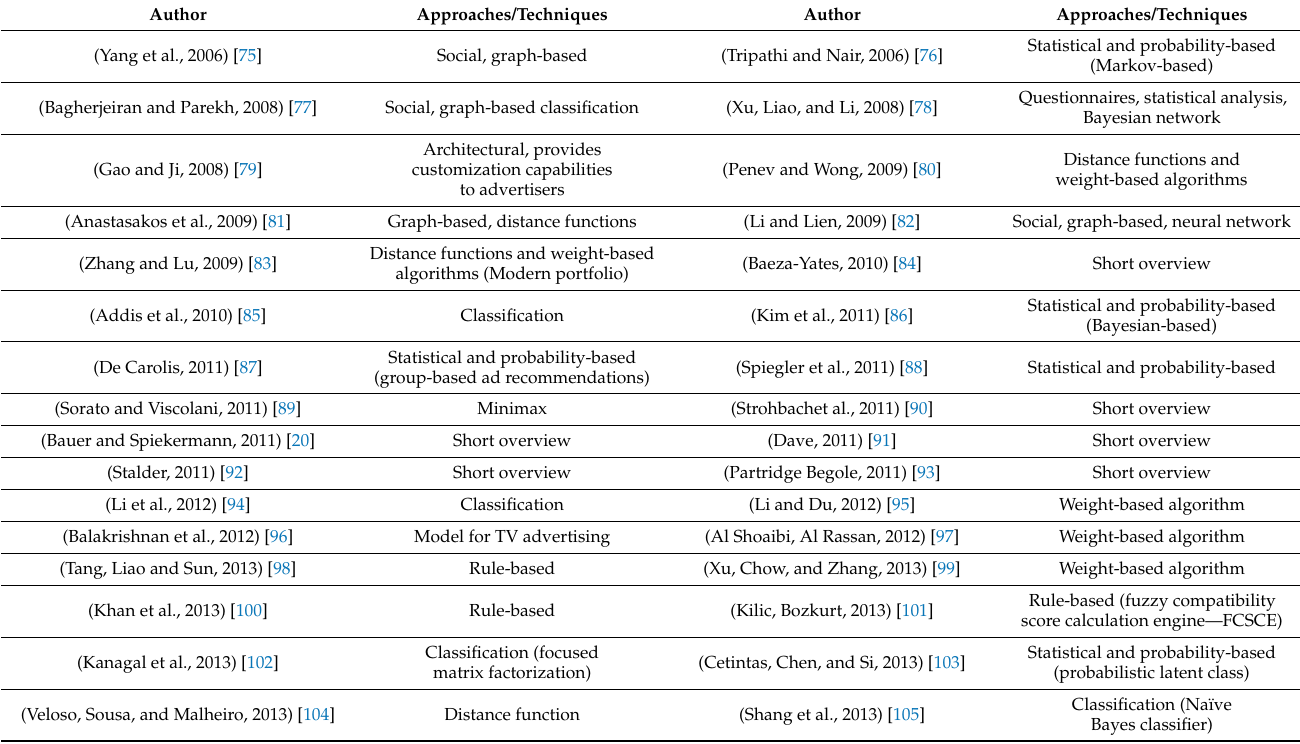
Table A1. Research in computational models that predict user interest towards